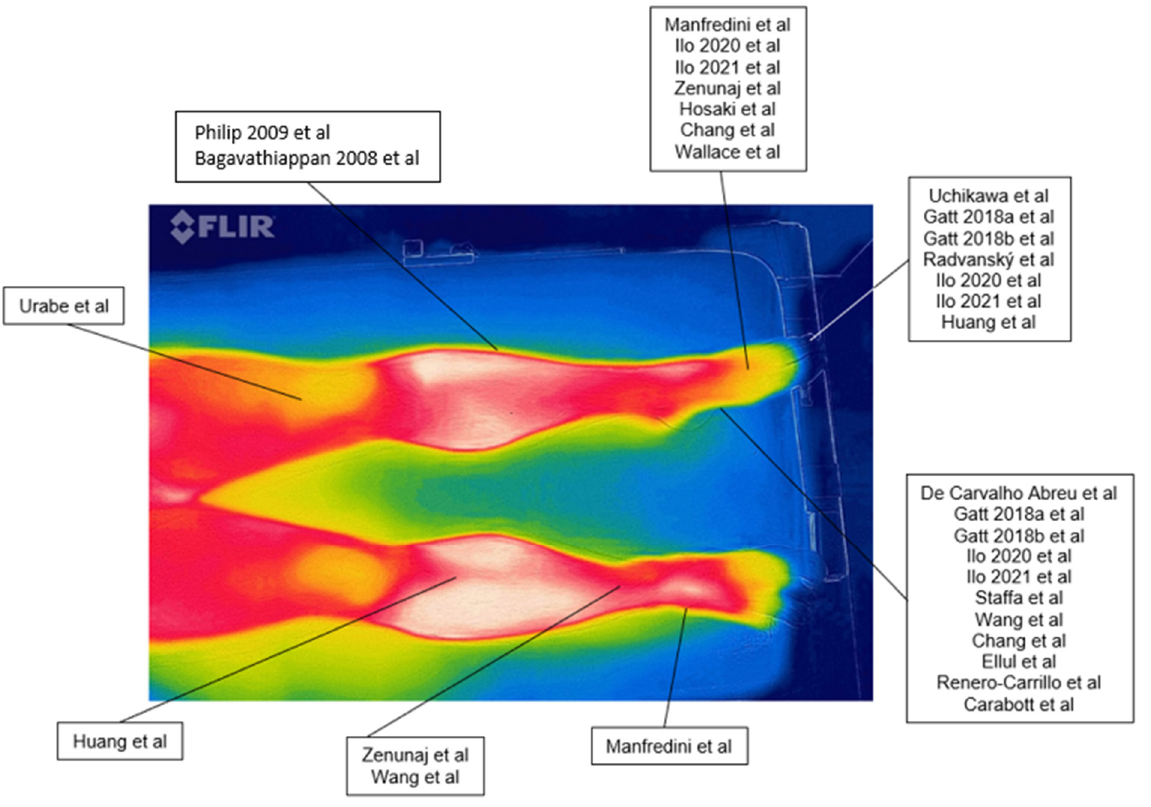
Figure 2. Example of a thermographic image with the site of the collection according to each study. References: [2,21 − 22,32 −